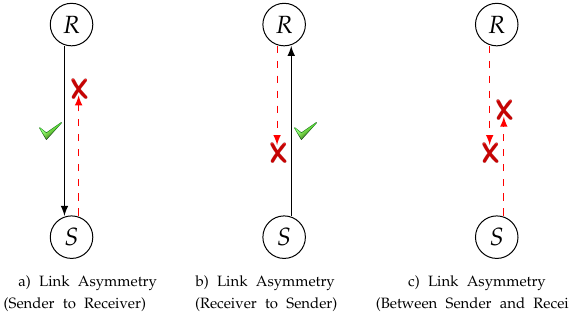
Figure 1. Asymmetric link